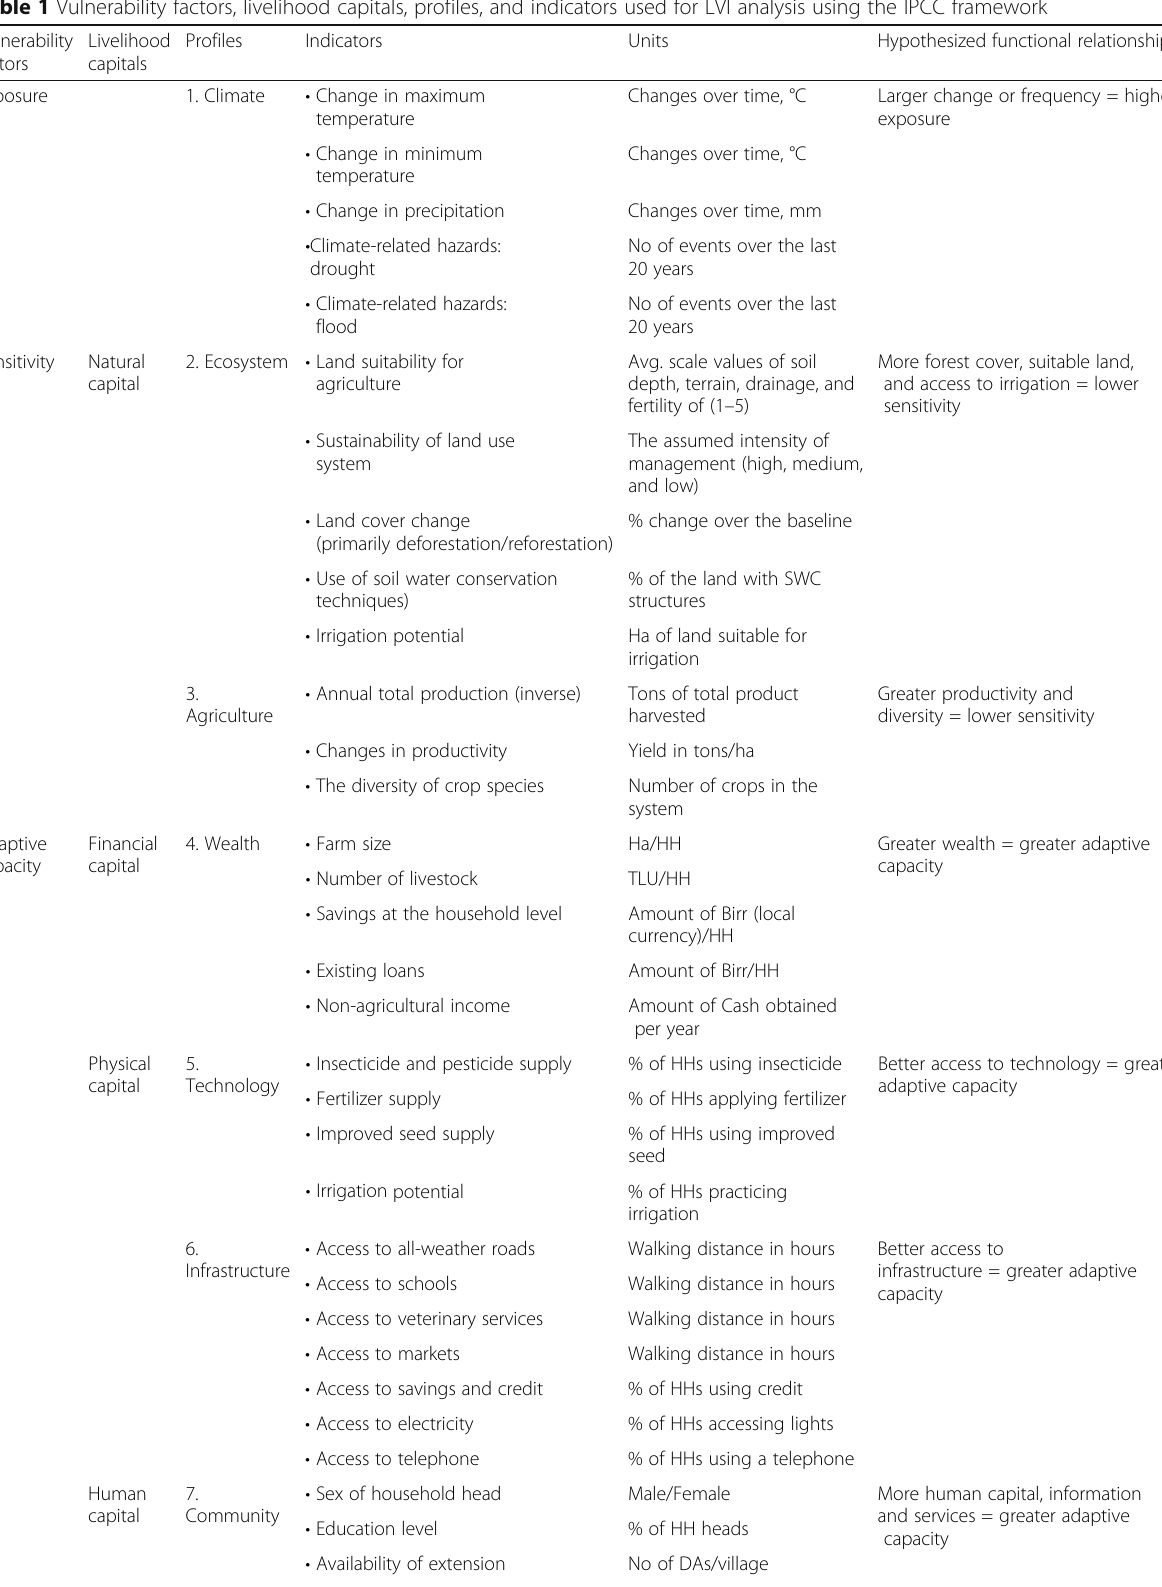
Table 1 Vulnerability factors, livelihood capitals, profiles, and indicators used for LVI analysis using the IPCC